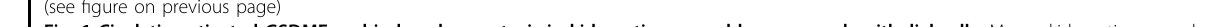
Fig. 1 Cisplatin activated GSDME and induced pyroptosis in kidney tissues and human renal epithelial cells. Mouse kidney tissues and human renal epithelial cells subjected to cisplatin were used to determine the expression of GSDME and the existence of pyroptosis. a Protein level of FL-GSDME and GSDME-N in mouse kidneys subjected to cisplatin ( n = 4). b Renal IL-1 β production in mice subjected to cisplatin ( n = 6). c Protein level of cleaved caspase-3 in mouse kidneys after cisplatin treatment ( n = 3). d Protein levels of FL-GSDME, GSMDE-N, caspase-3, and cleaved caspase-3 in cells treated with different doses of cisplatin for 24 h ( n = 3). e LDH release in cells treated with different doses of cisplatin for 24 h ( n = 6). f Protein level of FL-GSDME, GSMDE-N, caspase-3, and cleaved caspase-3 in cells treated with 10 μ g/mL of cisplatin for different time intervals ( n = 3 – 4). g LDH release in cells treated with 10 μ g/mL cisplatin for different time intervals ( n = 6). h Representative bright- fi eld (scale bar = 50 μ m) and transmission electron microscopy (magni fi cation × 10000; scale bar = 2 μ m) of cells incubated with cisplatin or the corresponding control. Red arrowheads indicate large bubbles and pores emerging from the plasma membrane. * P < 0.05, ** P < 0.01, and *** P <